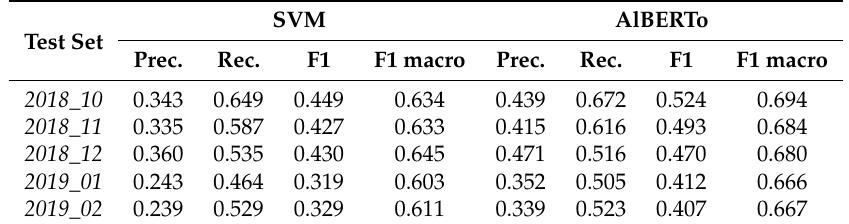
Table 7. Numerical results of the evaluation of the model trained on Incremental and Haspeede+ dataset. SVM AlBERTo Test Set Prec. Rec. F1 F1 macro Prec. Rec. F1 F1